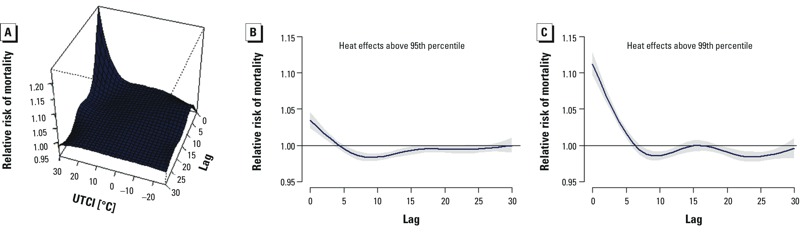
Three-dimensional DLNM outputs of the relative risk of mortality along equivalent temperature and lags for all-cause mortality (A) and plots of relative risk of mortality at the 95th (B) and 99th (C) percentiles of equivalent temperature distribution (corresponding to a UTCI of 19.9°C and 24.8°C, respectively), with reference at the median equivalent temperature (8.3°C UTCI) where the relative risk equals 1 for the elderly above the age of 65 years. Outputs are adjusted for long-term and seasonal trend (6 df per year), daily averages of O3 and PM10 (lags 0–1). Grey areas represent the upper and lower 95% confidence intervals.